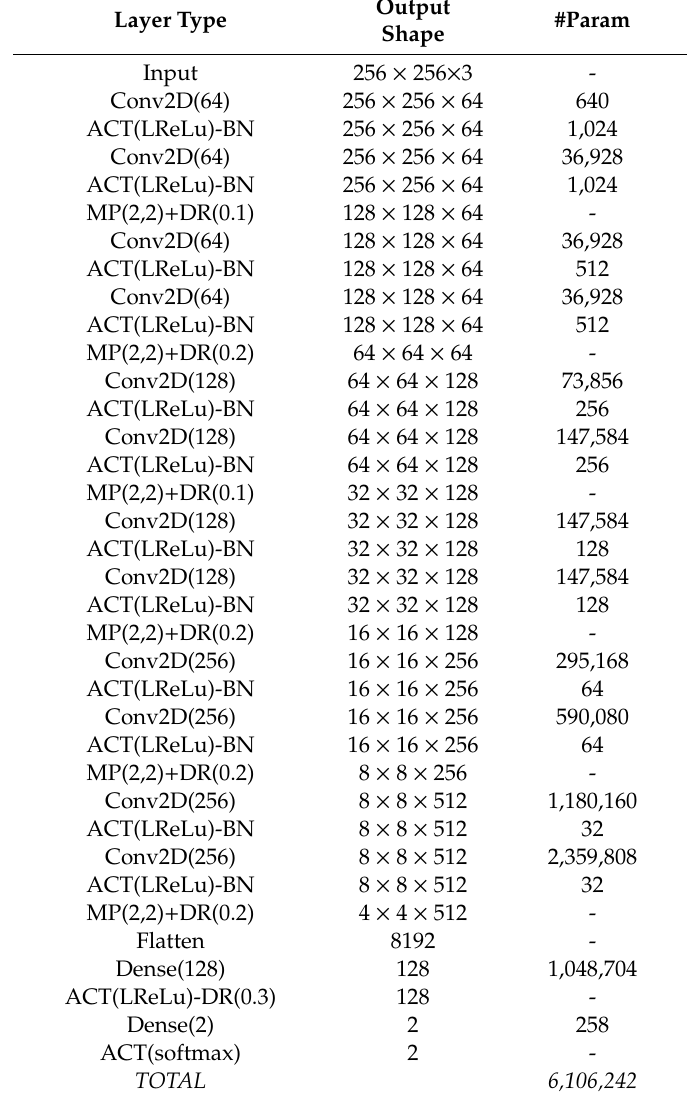
Table 2. Detailed architecture of proposed custom